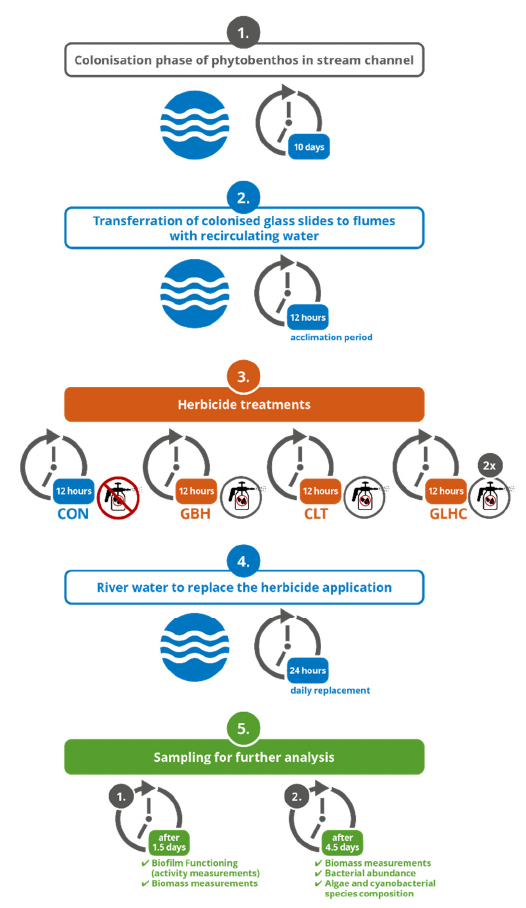
Figure A1. Schematic illustration of the study design.